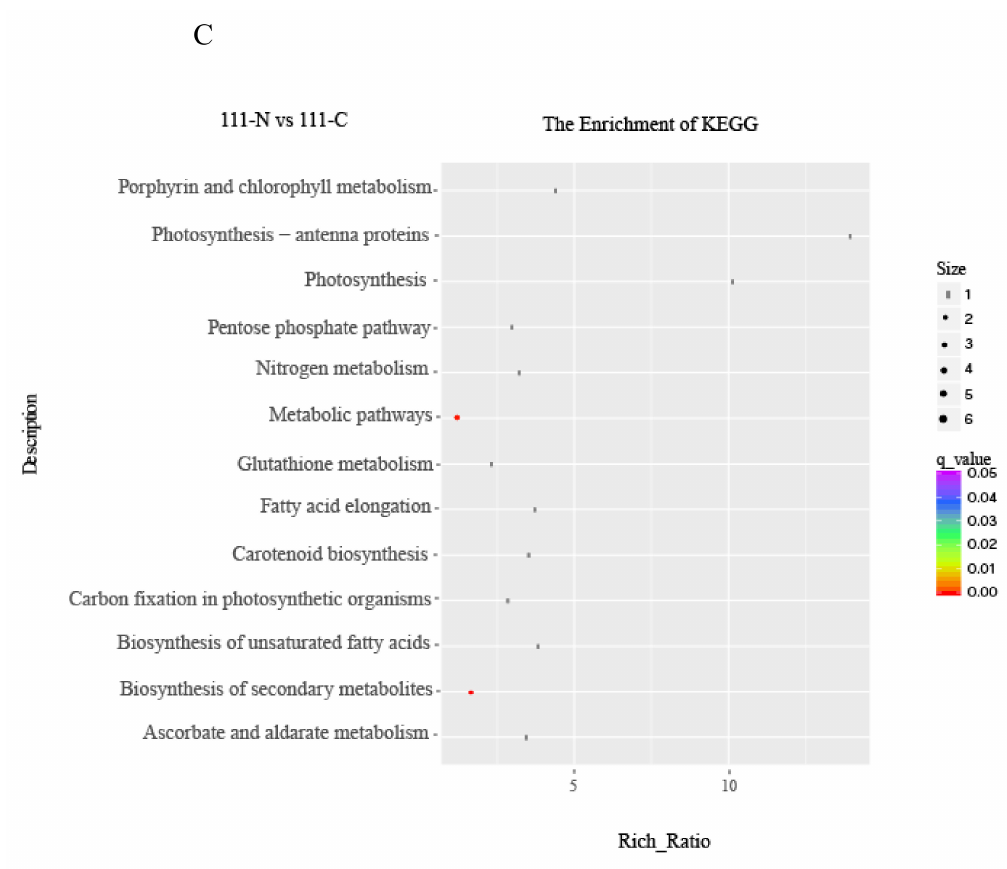
Figure 6. Kyoto Encyclopedia of Genes and Genomes (KEGG) pathway analysis of DEGs among the ‘108’ and ‘111’ treatment groups. DEG pathway enrichment between ( A ) oviposited and control leaves of ‘108’, ( B ) oviposited and control leaves of ‘111,’ and ( C ) neighboring and control leaves of ‘111’. Each point indicates the degree of enrichment of the KEGG entry. The closer the color is to red, the higher the degree of enrichment. The size of each point indicates the number of genes that are enriched in the KEGG entry, and the larger the point, the more genes that are